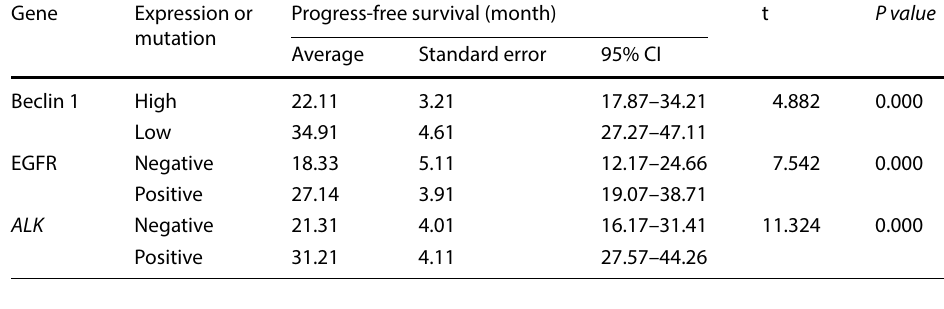
Table 3 Relationship between progress-free survival and Beclin 1 expression, EGFR and ALK rearrangements in lung cancer patients